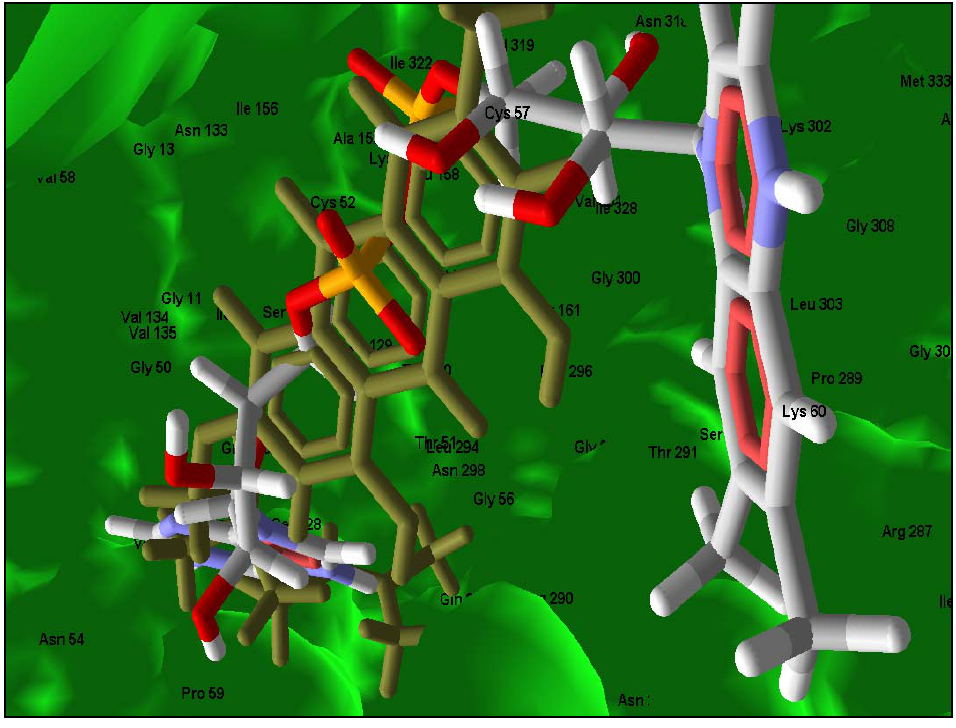
Figure 7. A close up on the orientation of 3-geranylemodin (brown) and FAD (white, red and blue) on a solid surface of